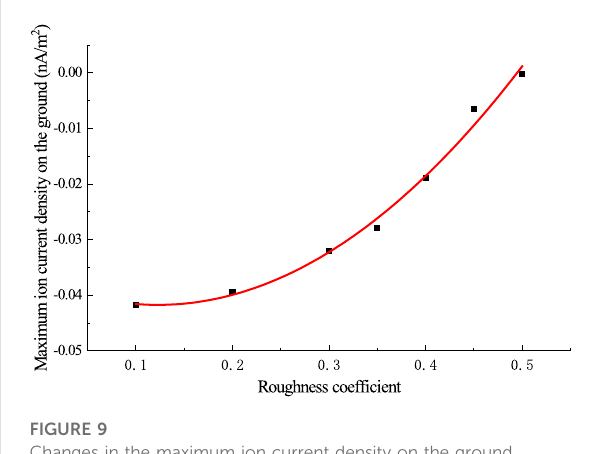
FIGURE 8 Ion current density distribution on the ground under ± 800 kV power lines with different roughness coef fi cients.